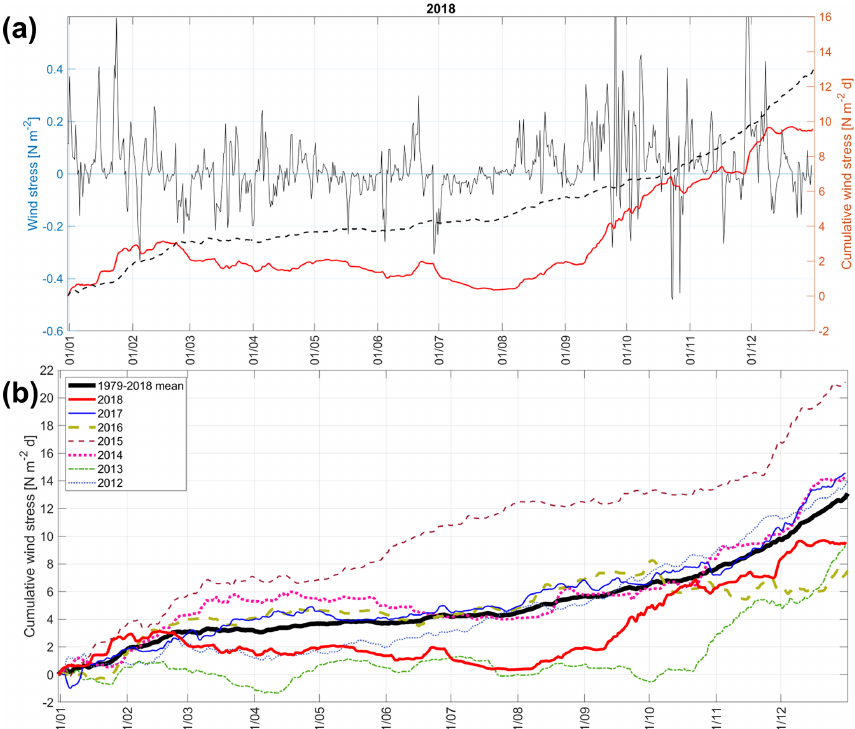
Figure 8. (a) Time series of along-coast (NNE–SSW) component of wind stress τ NNE and cumulative wind stress in 2018 (6h moving average is shown). (b) Cumulative wind stress for each year in 2012–2018. Average cumulative wind stress curve for 1979–2018 is shown in both panels. Data were extracted from the ERA5 grid point outside the gulf (see location in Fig. 1).